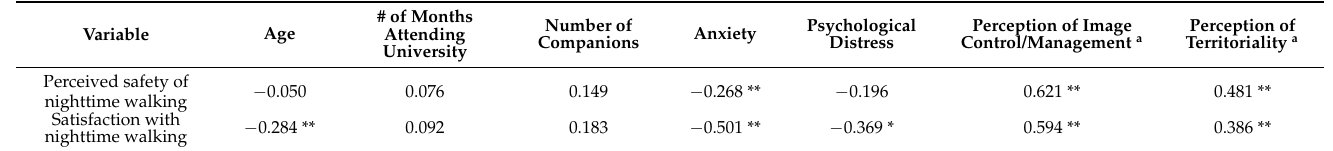
Table 8. Correlation between the perceived safety of campus and other measures for the non-music- listening group ( n = 100).